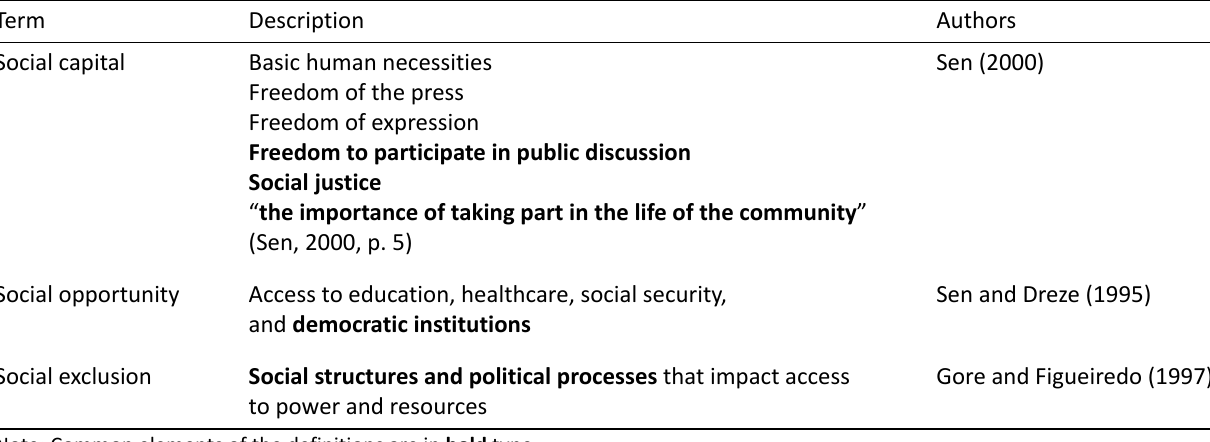
Table 1. Definitions of social